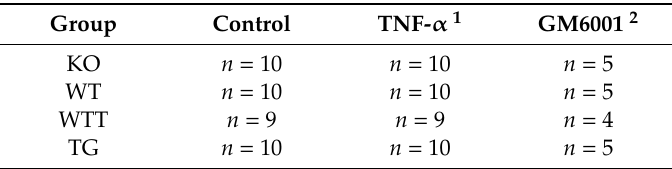
Table 2. Experimental groups.